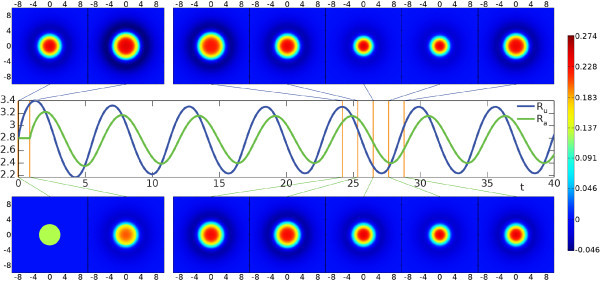
Breathing instability from direct numerical simulation with parameters α=5, β=0.5, γ=4, coupling strength g=0.5 and Heaviside threshold h=0.12/(1+g). Initial data was constructed from a stationary spot solution by modifying the adaptation variable to a top-hat shape. Top and bottom rows: snapshots of activation u and adaptation a, respectively, at times indicated by orange lines in the middle row. Middle row: above threshold radii as function of time. See also the video in Additional file 6.